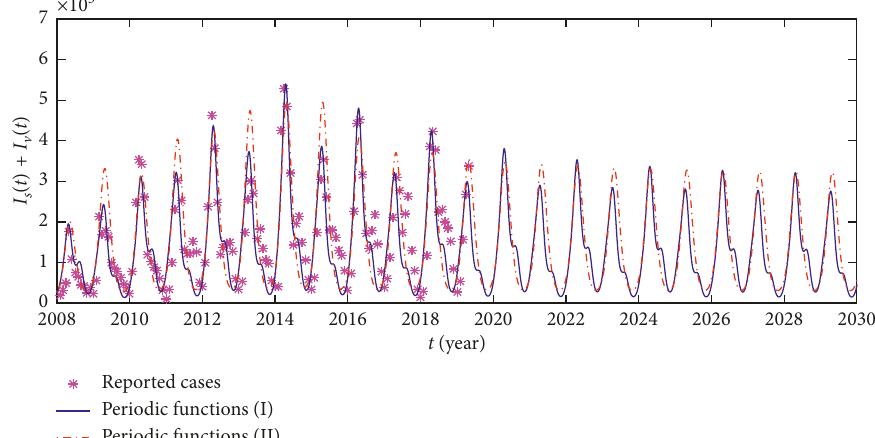
Figure 7: The tendency of HFMD from system (1)with periodic functions (I) and with periodic functions (II). The values of other parameters and the initial conditions are the same as in Figure 3.